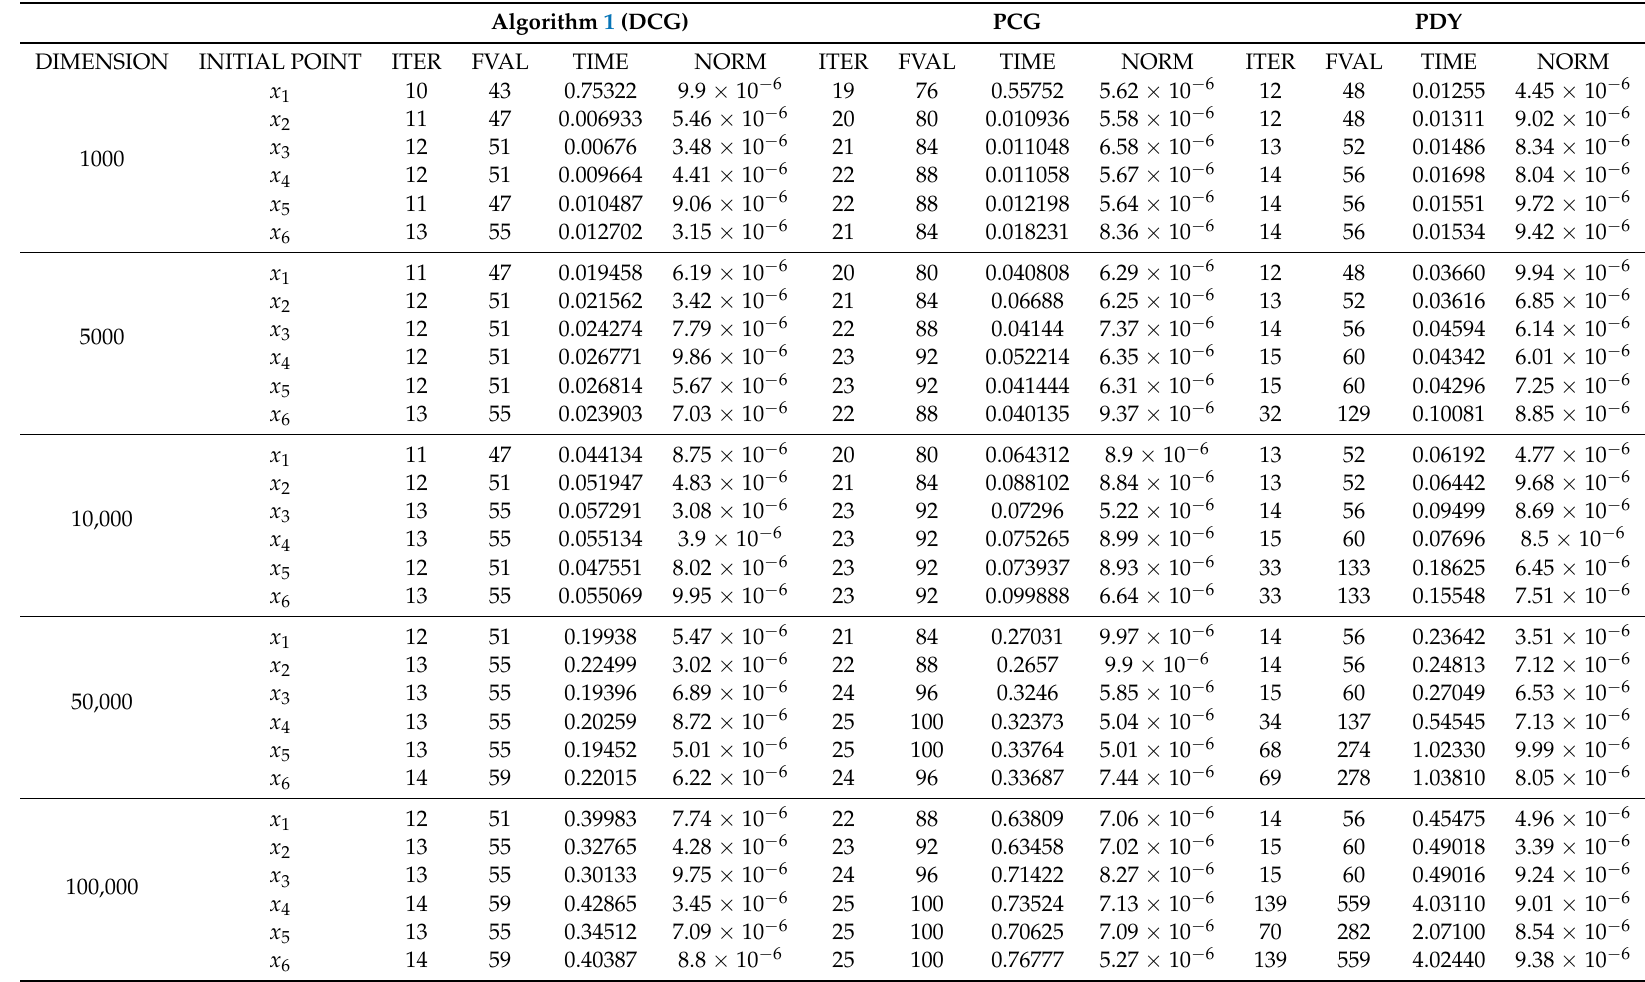
Table 3. Numerical Results for Algorithm 1 (DCG) , PCG and PDY for Problem 3 with given initial points and